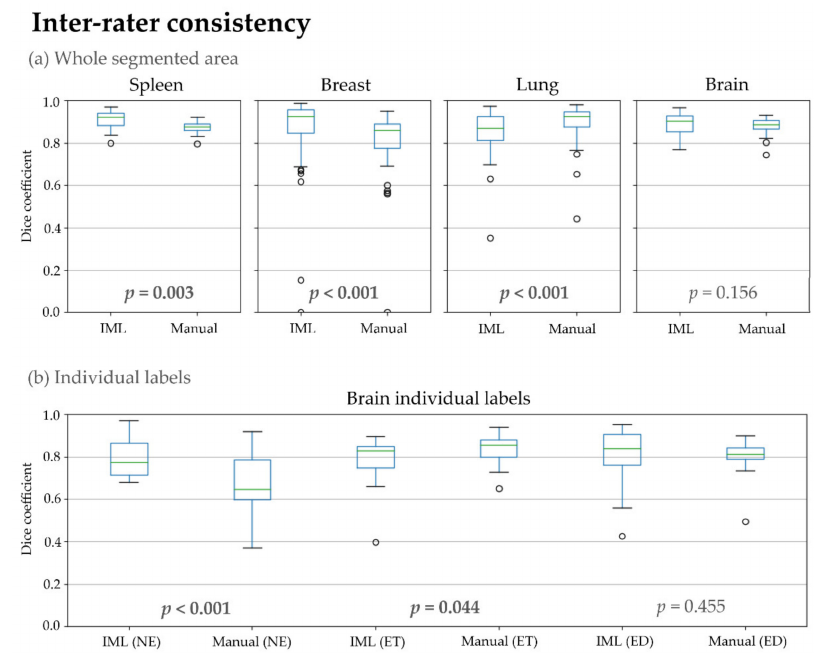
Figure 7. Dice coefficient, for inter-rater consistency, between segmentations of different raters, where: ( a ) All individual labels representing different areas of the structure counted as one; ( b ) Individual areas of